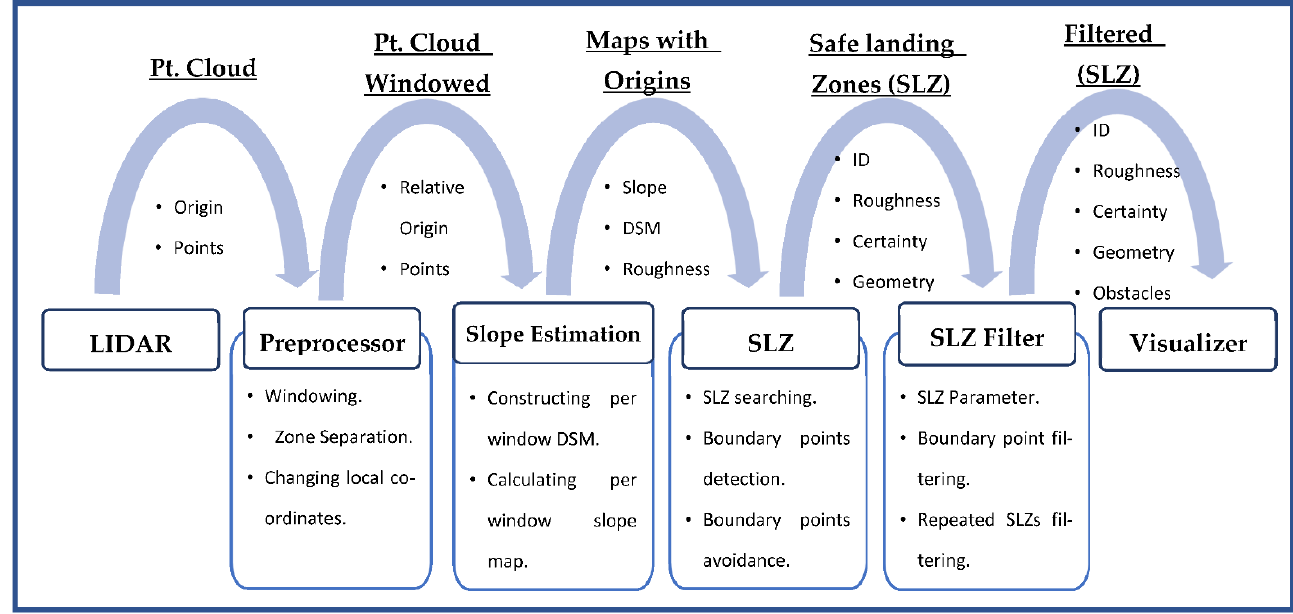
Figure 1. Overall system